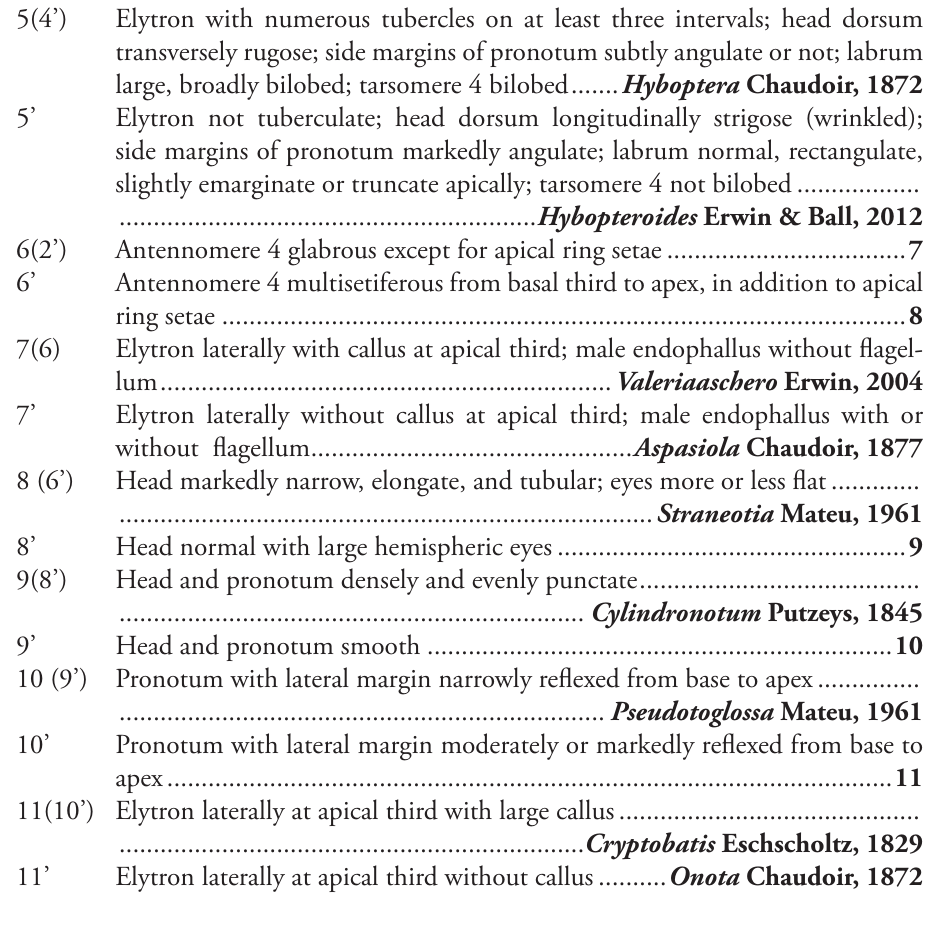
Hyboptera Chaudoir, 1872: 161. Type species: Hyboptera angulicollis Chaudoir, 1872: 164, designated by Reichardt (1973:50). Aspasia Reiche, 1842: 310 (not Dejean 1831). Type species: Aspasia verrucosa Reiche, 1842: 310. Synonymized by Chaudoir 1872: